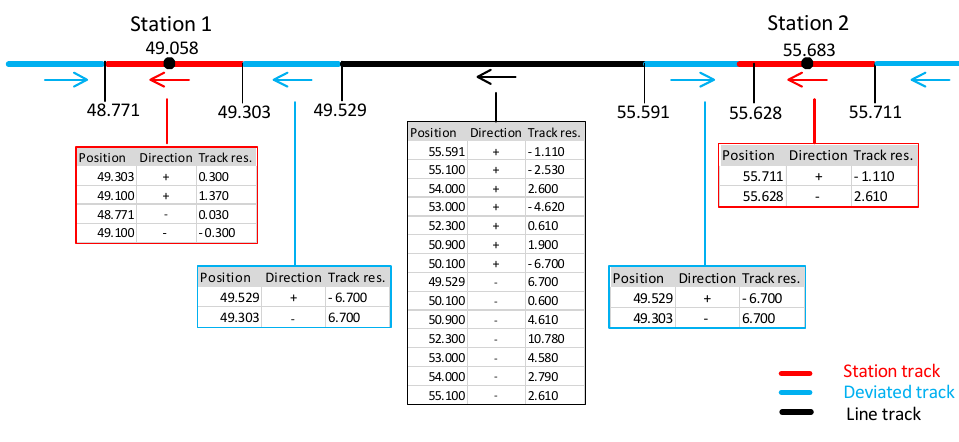
Figure 16. Reduced track profile.